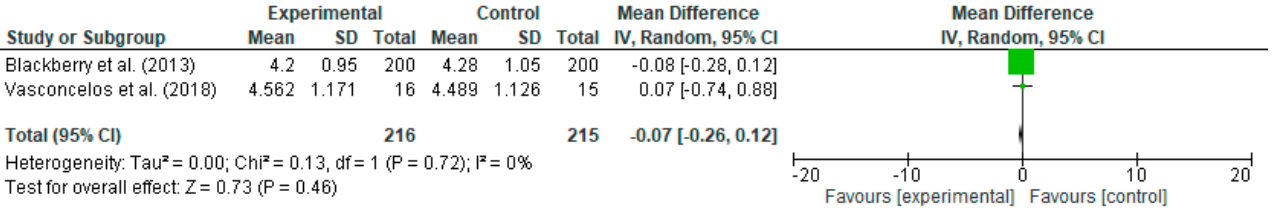
Figure 9. Forest plot intervention vs. control of telecoaching in achieving a total cholesterol outcome [12,15].